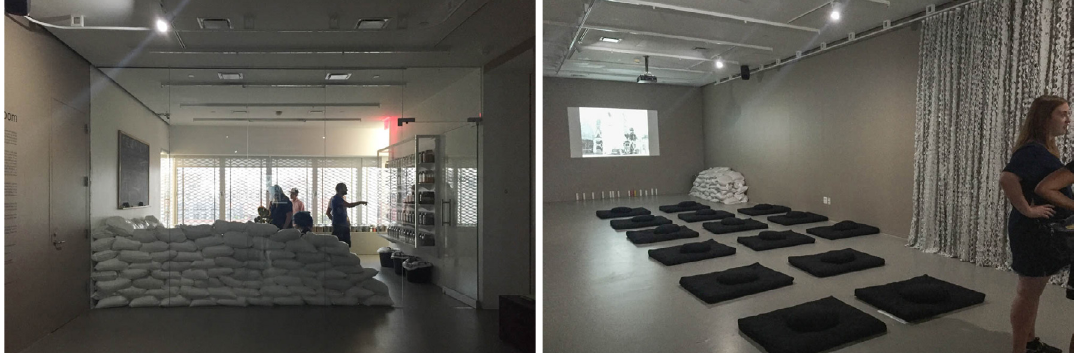
Figure 4 . Installation View, Simone Leigh : The Waiting Room , New Museum, 2016. Photo credit: Erin